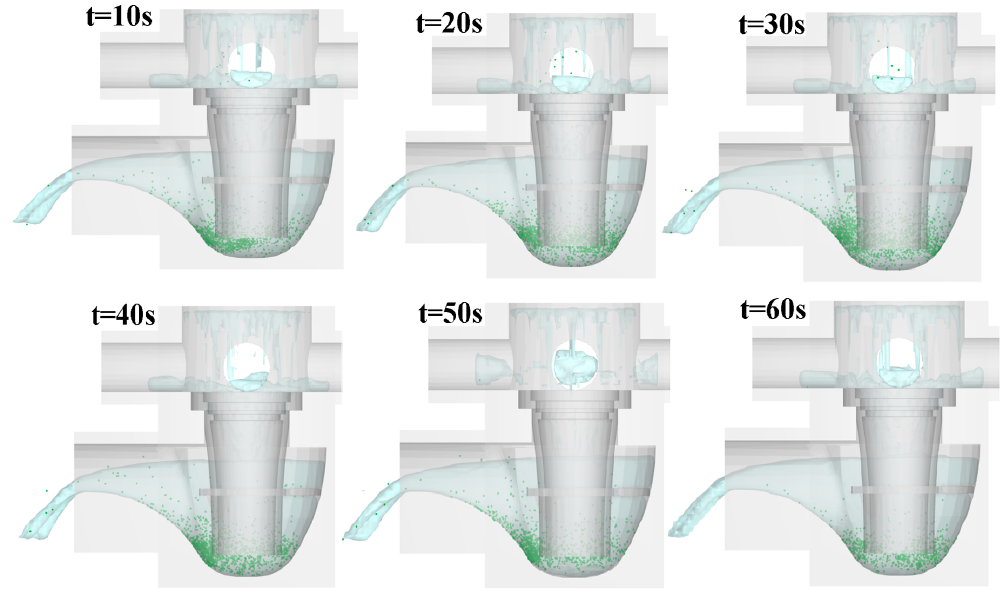
Figure 7. Temporal variations of glass ball transportation through gully with downward nozzle flow at entry water flow rate of 0.6 L/s.